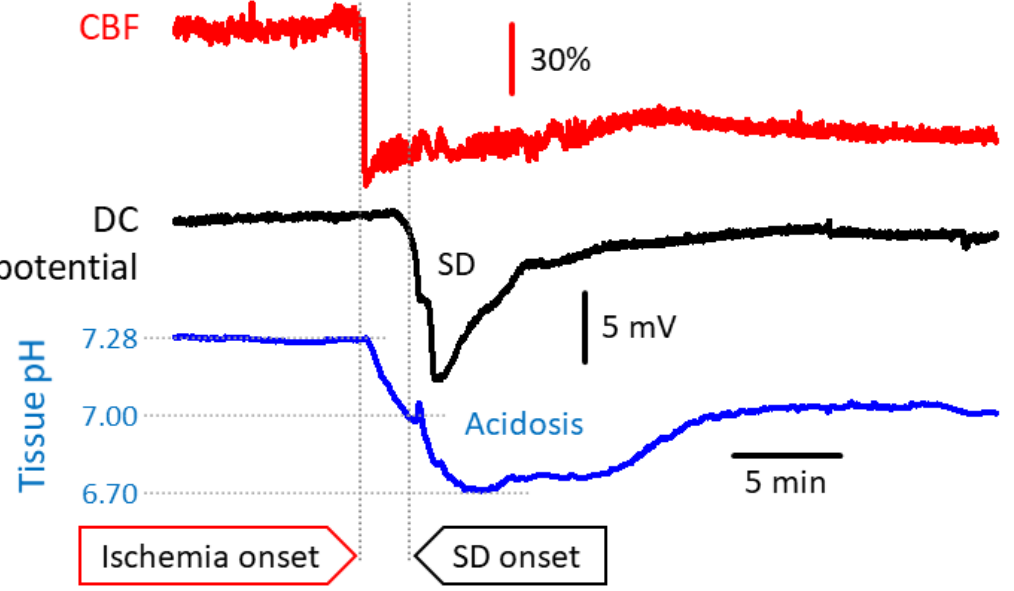
Figure 2. Representative traces demonstrate the association of tissue acidosis ( blue ) with ischemia onset (bilateral common carotid artery occlusion; ( red ) and spreading depolarization (SD); ( black ) in the rat parietal cortex. Tissue pH was measured with a pH-sensitive microelectrode implanted in the cortex, cerebral blood flow (CBF) was monitored with laser Doppler flowmetry, and the DC potential was acquired with an intracortical glass capillary